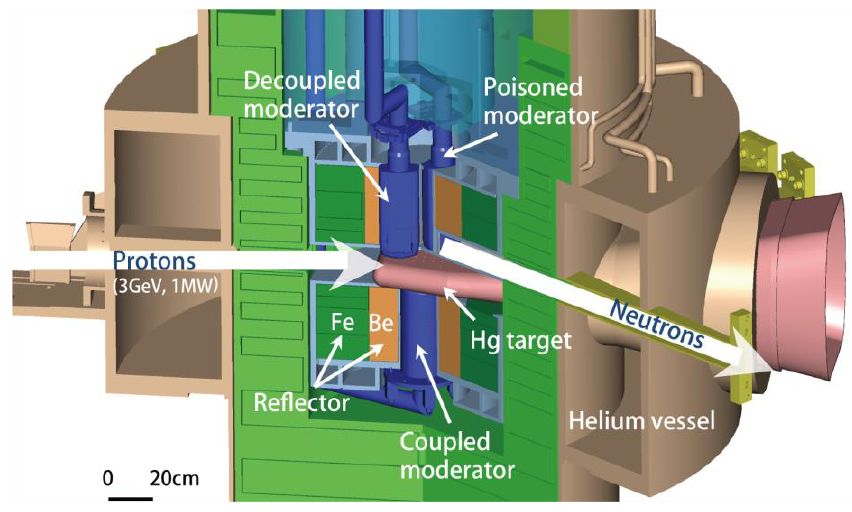
Figure 8. Cross sectional view of target-moderator-reflector.